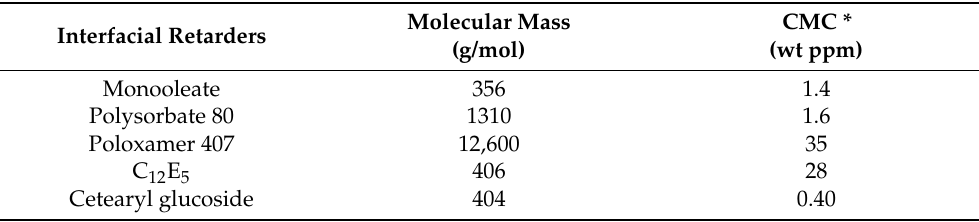
Table 2. Molecular mass and critical micelle concentration (CMC) of interfacial retarders monooleate, polysorbate 80, poloxamer 407, and cetearyl glucoside. Interfacial